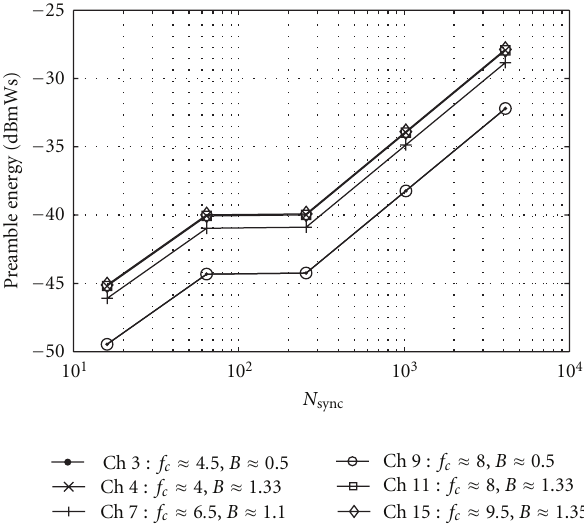
Figure 8: Allowed preamble energy for the specific IEEE802.15.4a